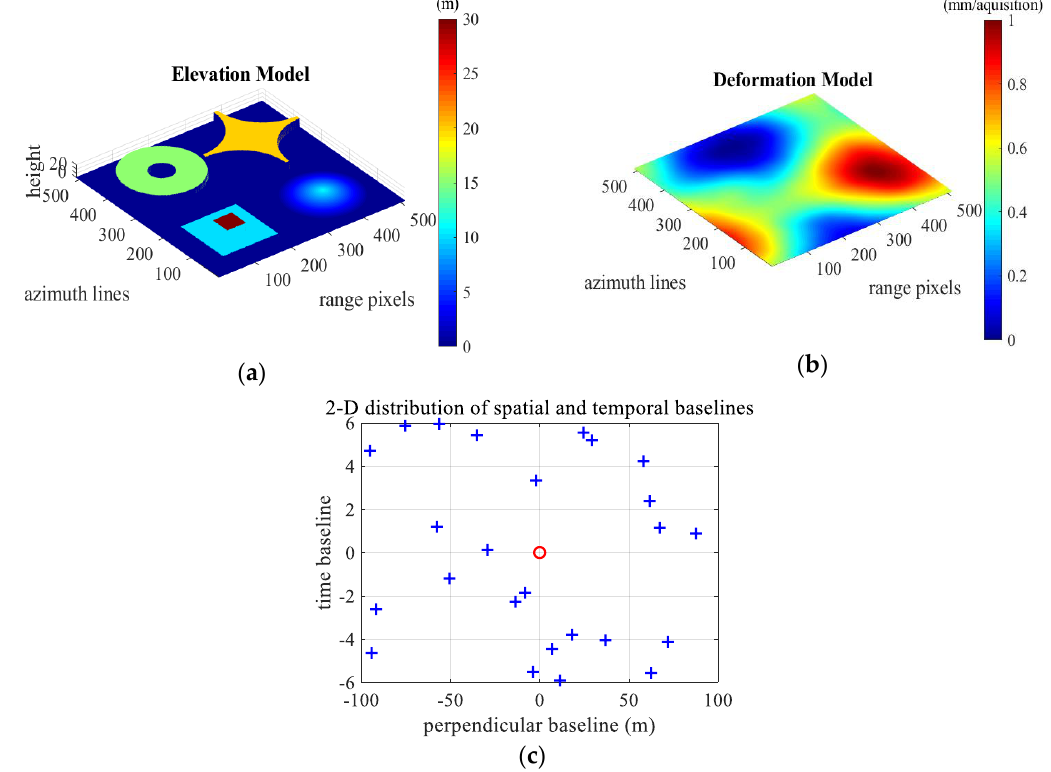
Figure 3. Illustration of a simulated example of ( a ) elevation model; ( b ) deformation model; ( c ) the 2-D distribution of temporal baseline and spatial baseline. The temporal baselines satisfy the uniform distribution. The spatial baselines are chosen as random distribution between [−100,100] m. Remote Sens. 2020 , 12 , x FOR PEER REVIEW